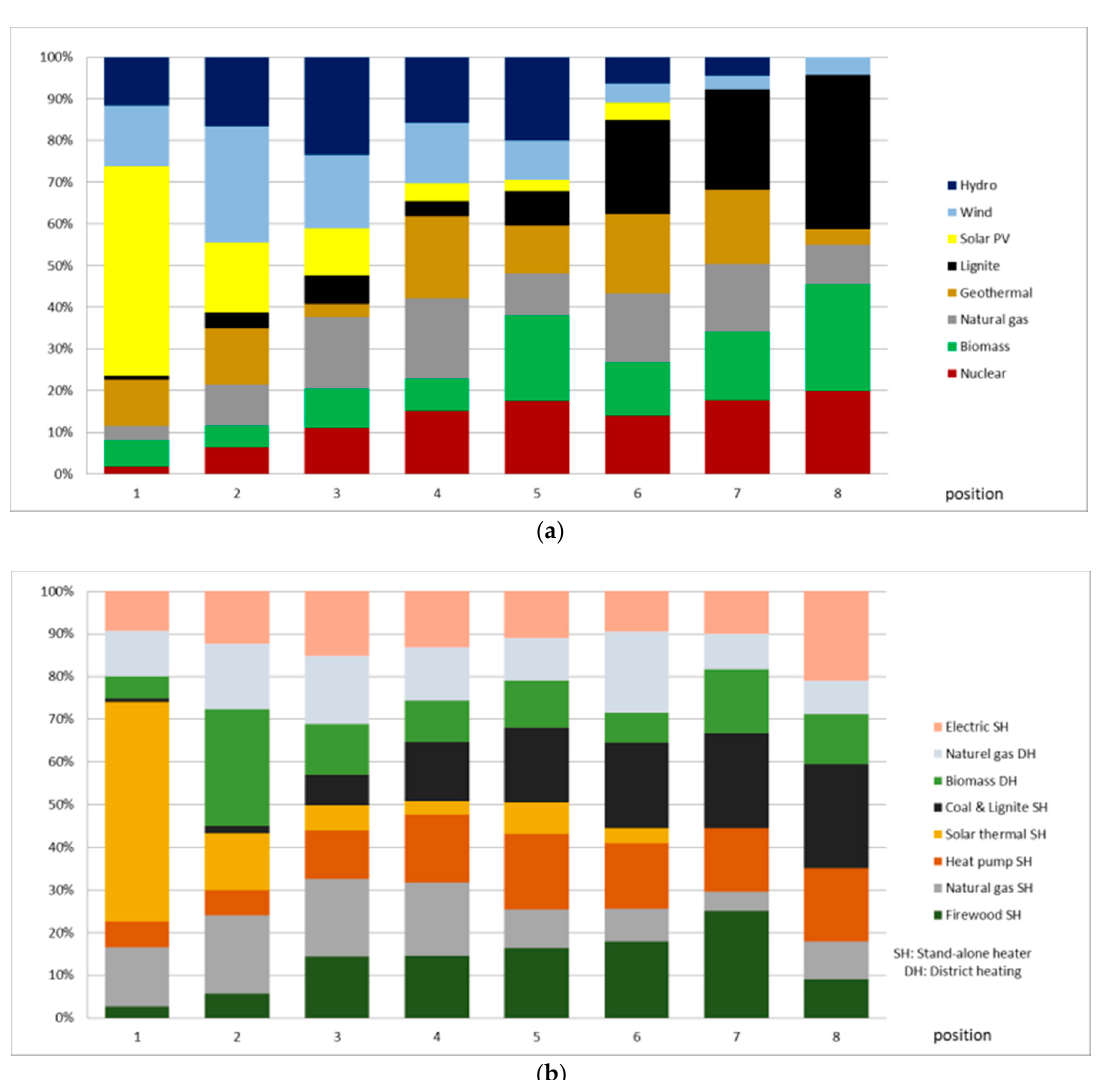
Figure 7. Medal table of ( a ) electricity production and ( b ) heating alternatives.